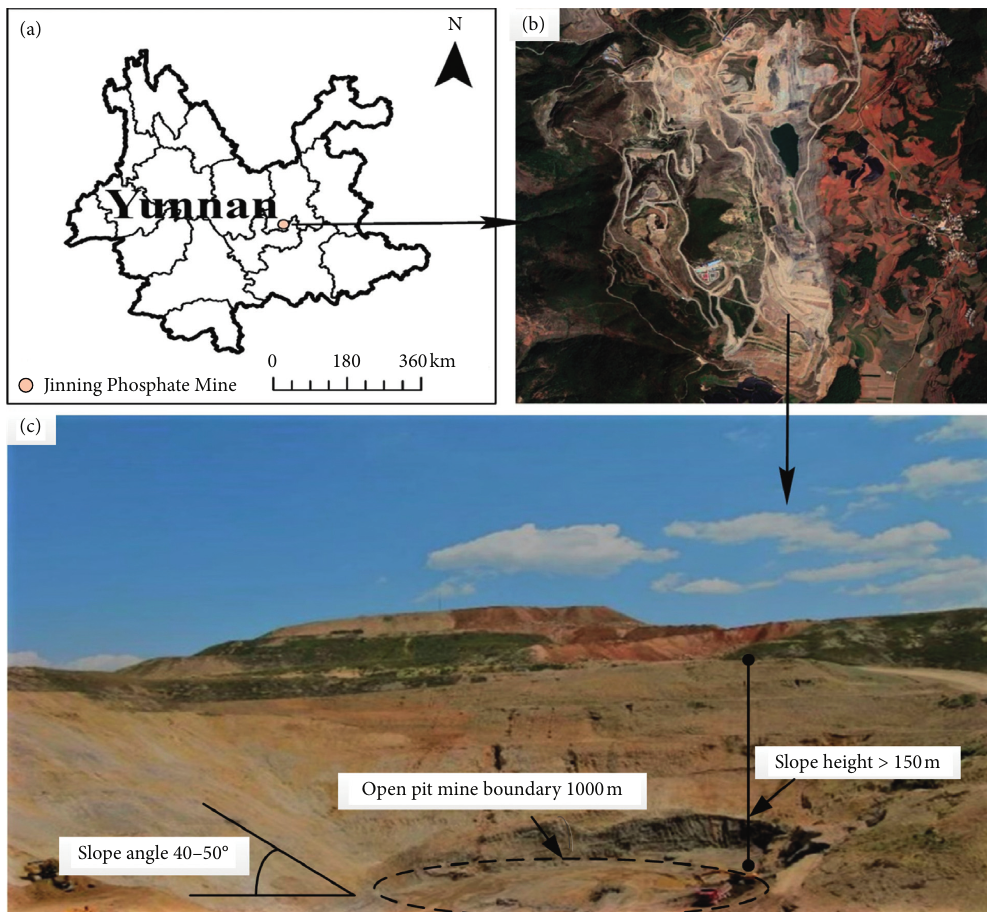
Figure 1: Geographical position and current mining operations at the Jinning Phosphate Mine in 2015: (a) location of the mine; (b) remote sensing image of the mine; (c) the current mine structure. Table 1: Proportion of the materials in each rock stratum of the similar physical model. Material ratio (sand: Rock stratum